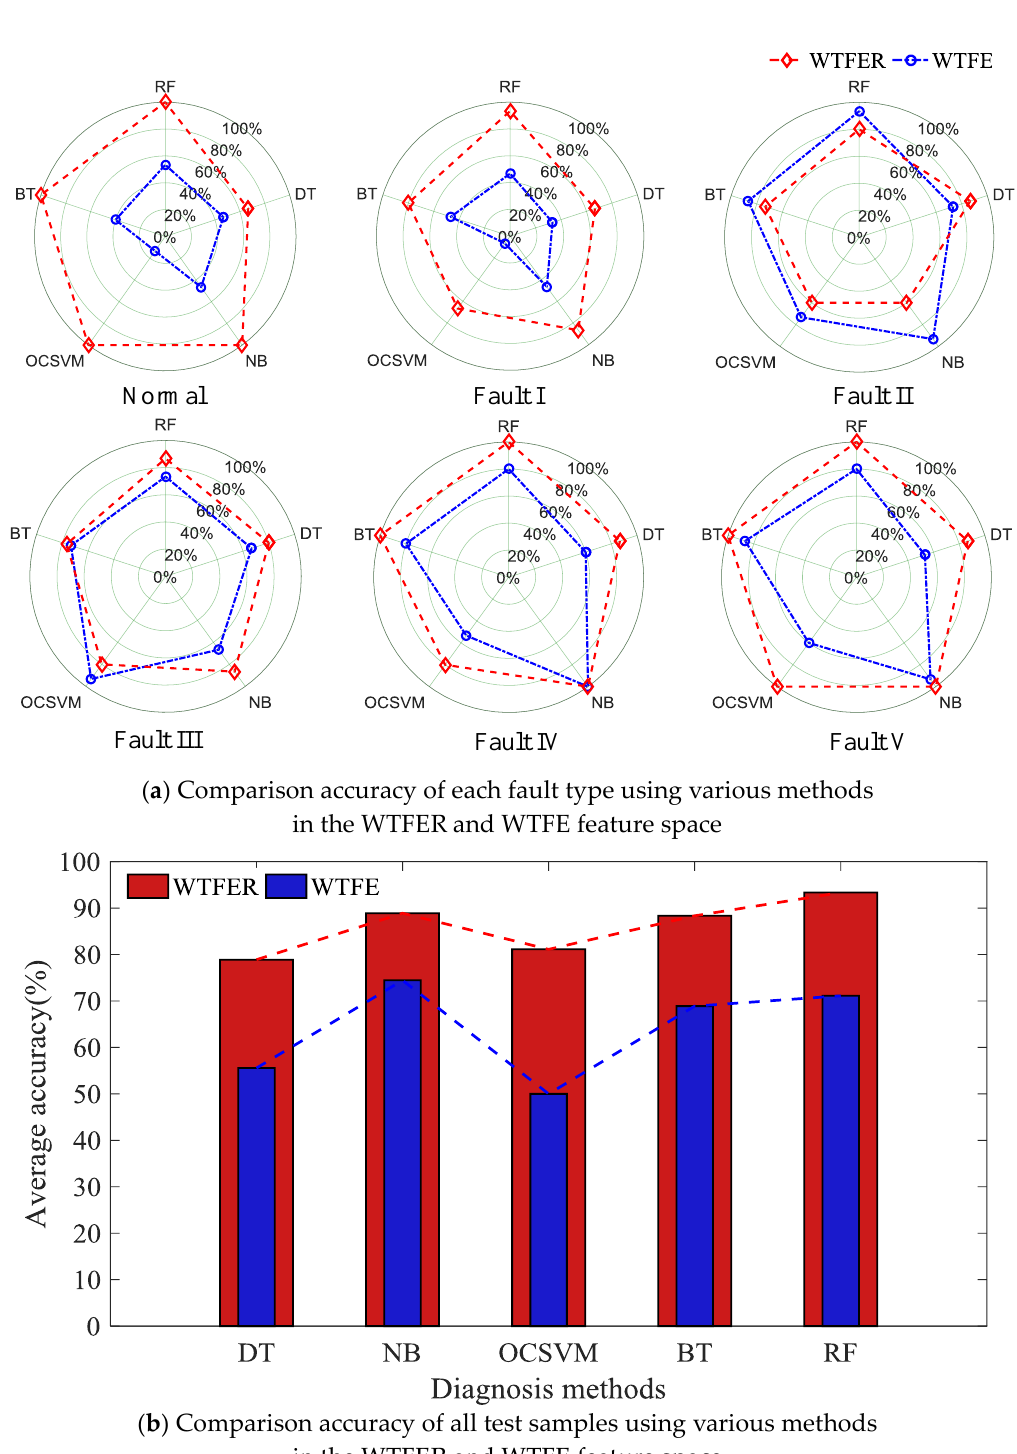
Figure 10. Diagnosis results based on WTFER feature space.